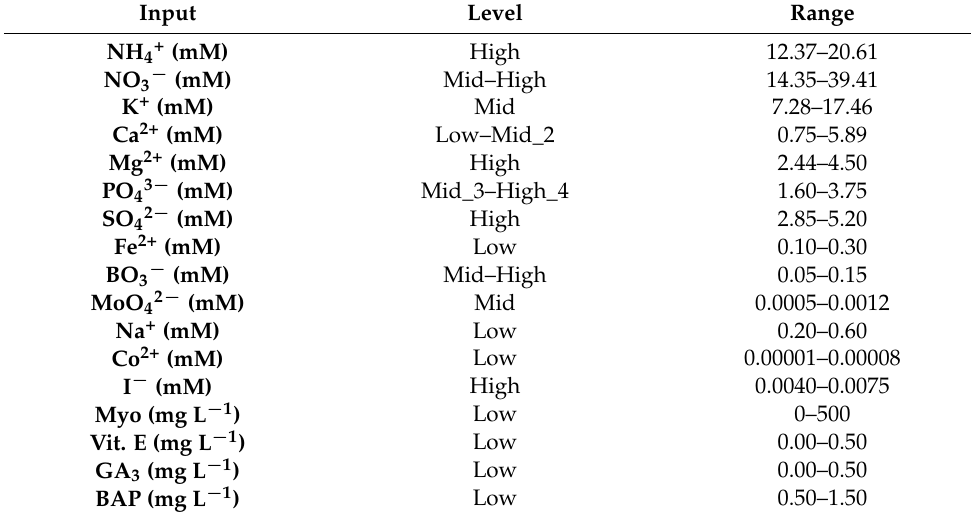
Table 4. Ranges (mM and mg L − 1 ) and meaning of the ideal levels (Low, Mid, and High) after the fuzzification process by neurofuzzy logic software to achieve the optimal parameter